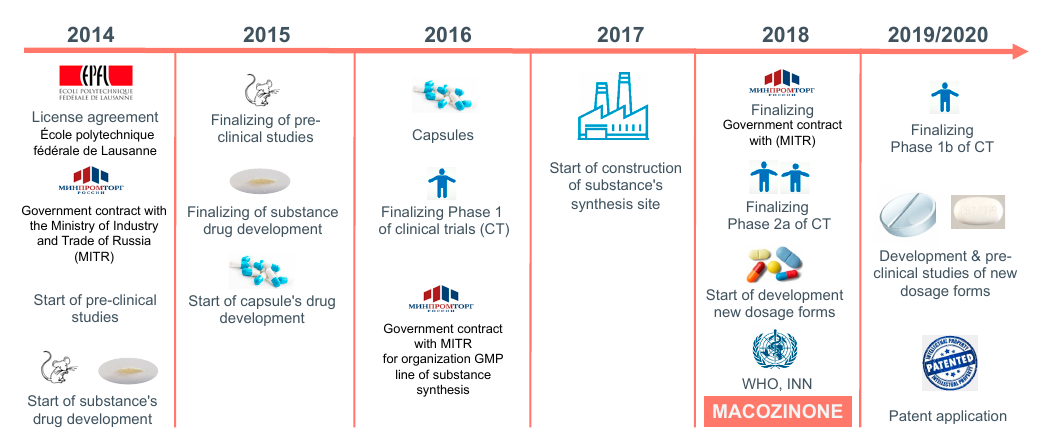
Figure 3. Pre-clinical and clinical development of Figure 3: Pre-clinical and clinical development of macozinone. 219